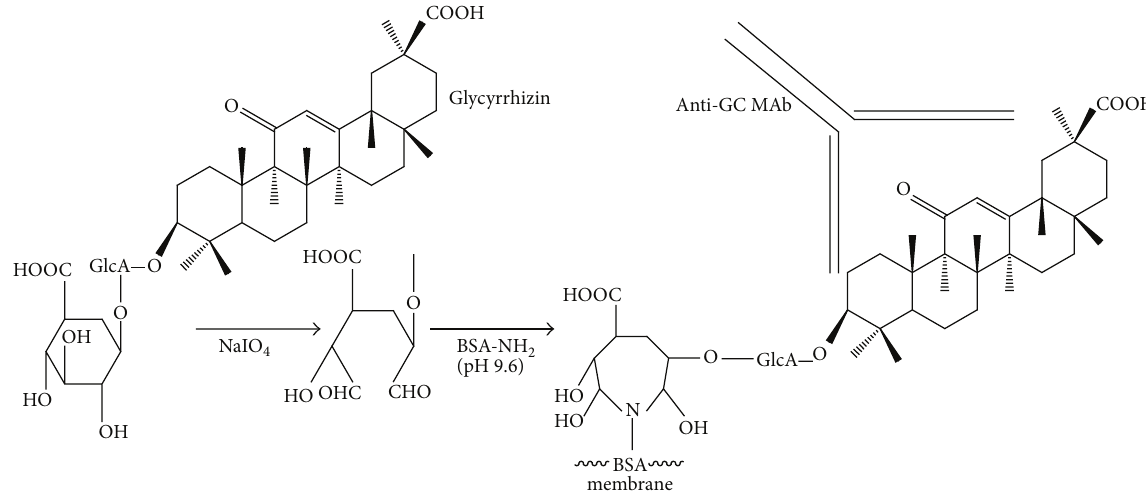
Figure 6: Scheme of eastern blotting for glycyrrhizin using antiglycyrrhizin MAb. Sugar moiety was cut by NaIO 4 to lease aldehyde group which conjugated to protein which can be fixed to membrane. An aglycone part was recognized by MAb resulting in staining.